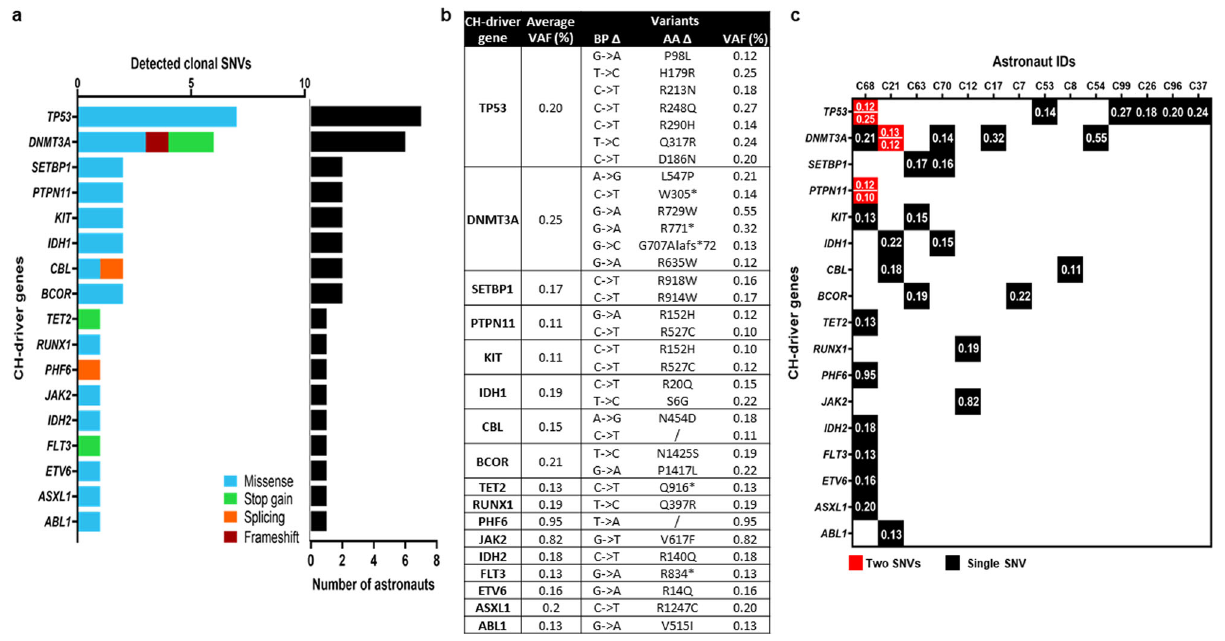
Fig. 2 Clonal Hematopoiesis (CH) Pro fi le of Astronauts. a Mutational pro fi le of 17 known mutated CHIP-driver genes and number of astronauts with mutations in each gene. b Table with average VAF, noted nucleotide (BP Δ ) and amino acid (AA Δ ) changes for each nonsynonymous mutation. Asterix (*) refers to terminated sequencing for stop gain mutations while backslash (/) corresponds to splicing mutations where AA Δ is not applicable. c Mutation plot for each individual is represented as columns. Each rectangle represents number of mutations identi fi ed in each gene, with black being 1 mutation and red 2 mutations, along with individual VAF (%) for each